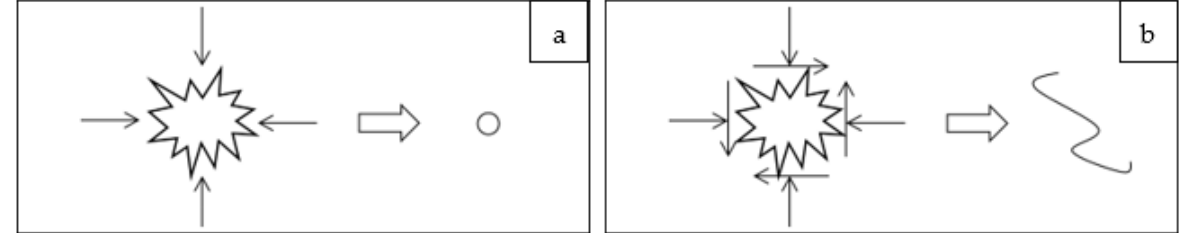
ing extrusion die, 2: billet, 3: extrusion cylinder, 4: extrusion pad, and 5: extrusion rod.